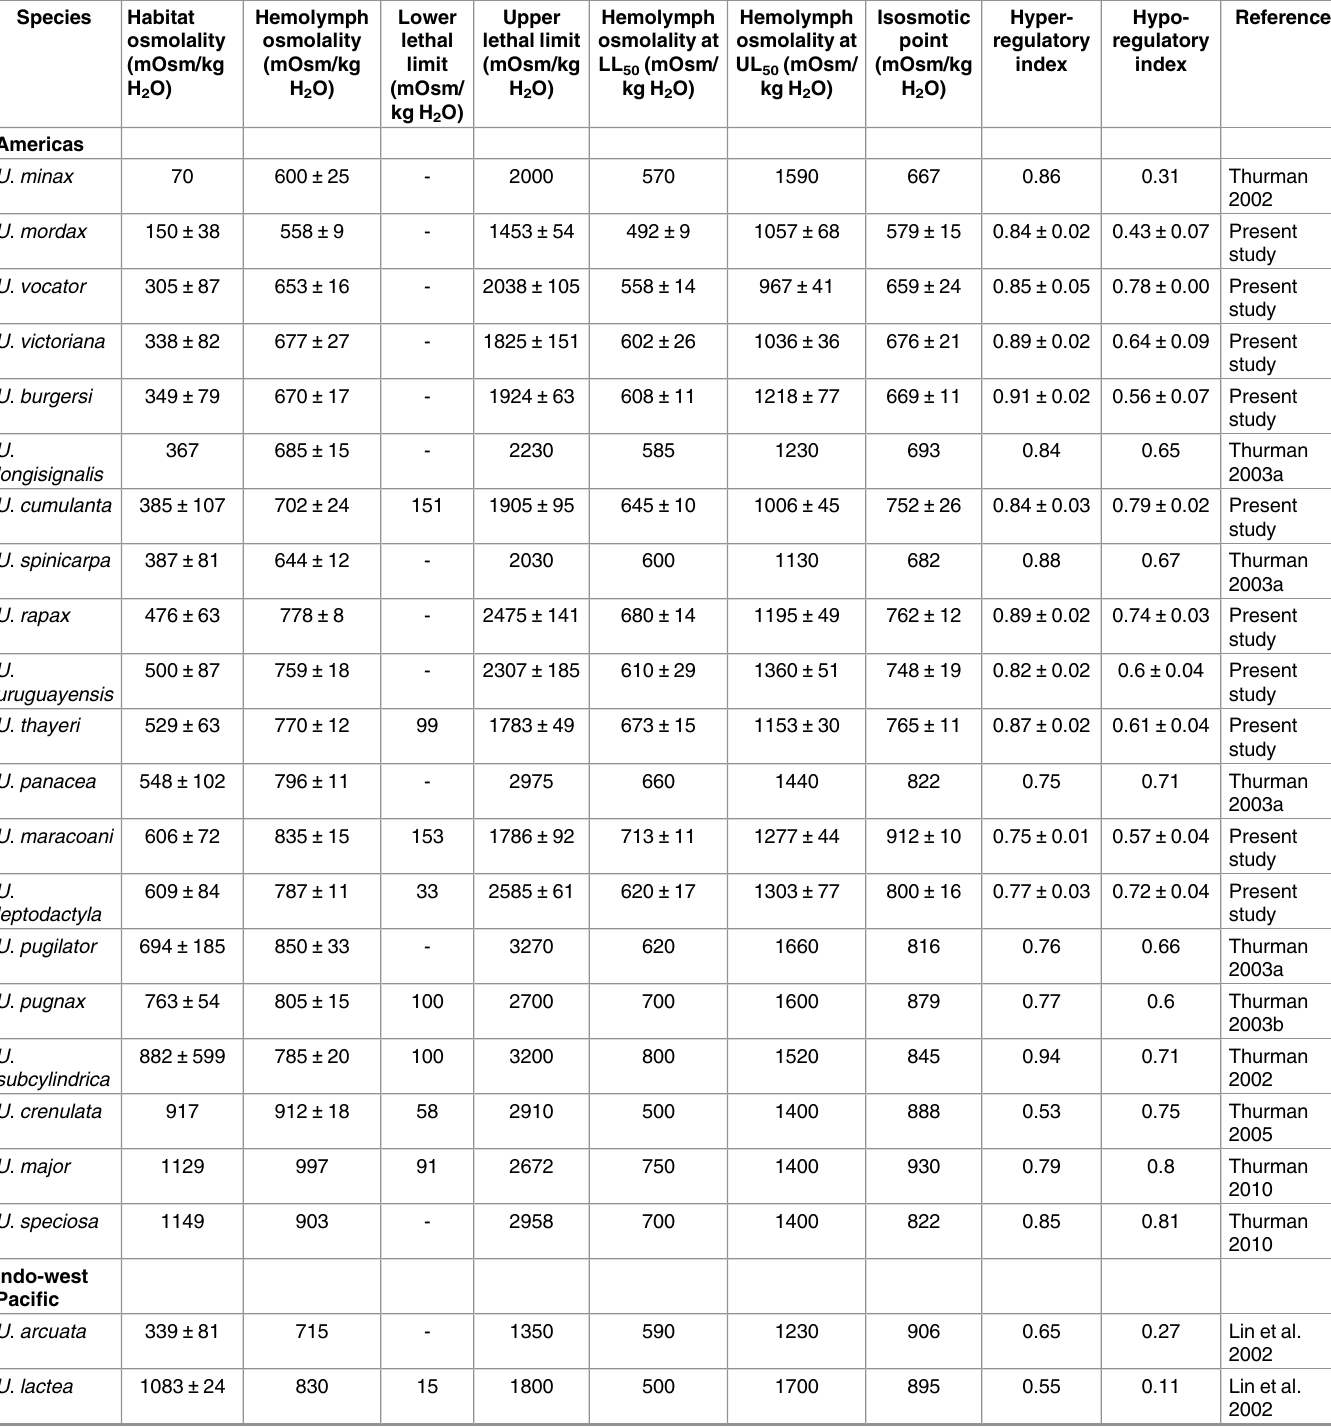
Table 1. Osmoregulatory traits for all Uca speciesevaluated to date from the American and Indo-west Pacific regions. We providehabitat and hemo- lymph osmolalities, lower